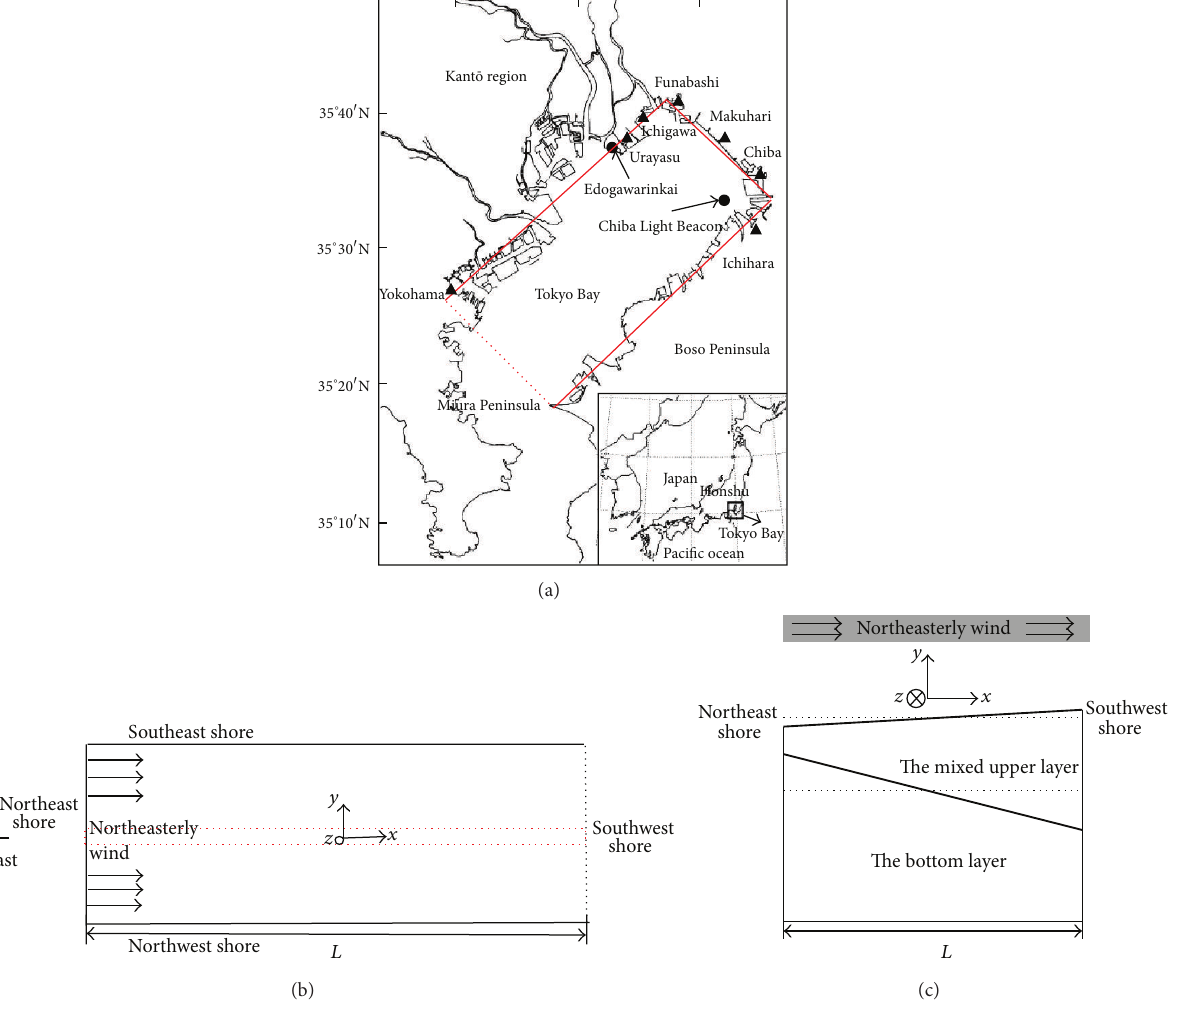
Figure 1: (a) Map of Tokyo Bay including the chosen research domain; (b) dimensions of the domain; (c) schematic diagram of coastal upwelling on the northeast shore, caused by the blowing of a northeasterly wind